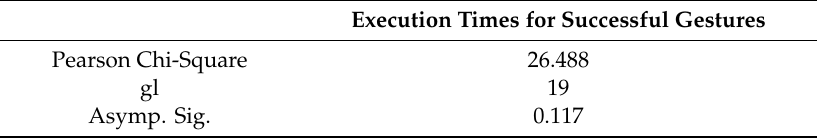
Table 7. Contrast statistics (Kruskal–Wallis test, grouping variable: ID_gesture).